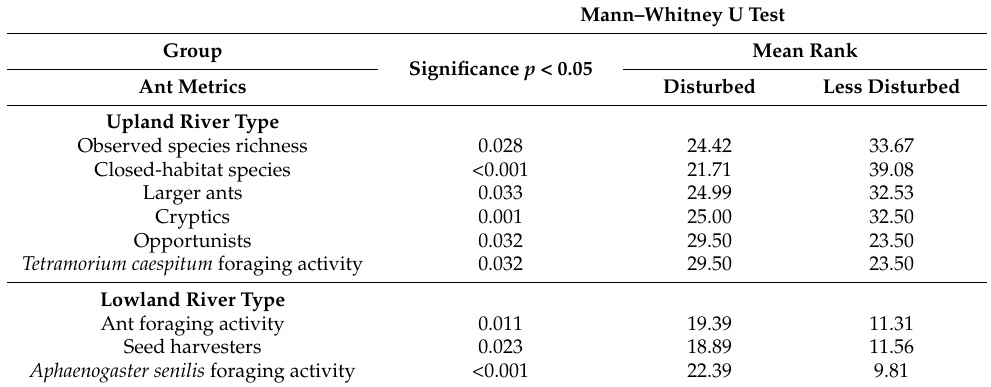
Table 2. Statistical comparison of the ant metrics that showed significant differences between disturbance groups in the upland and lowland river